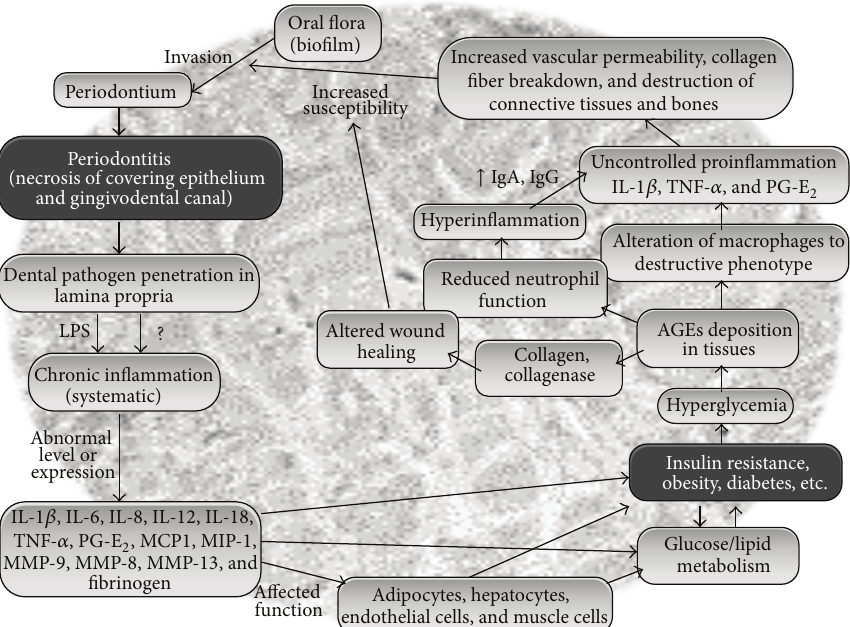
Figure 2: A summary of proposed connections between periodontal diseases and metabolic disorders such as obesity, insulin resistance, and type 2 diabetes (LPS: lipopolysaccharide; IL: interleukins; TNF: tumor necrosis factor; PGE2: prostaglandin E2; MCP: monocyte chemoattractant protein; MIP: macrophage inflammatory protein; MMP: matrix metalloproteinase; AGEs: advanced glycation end products; Ig: